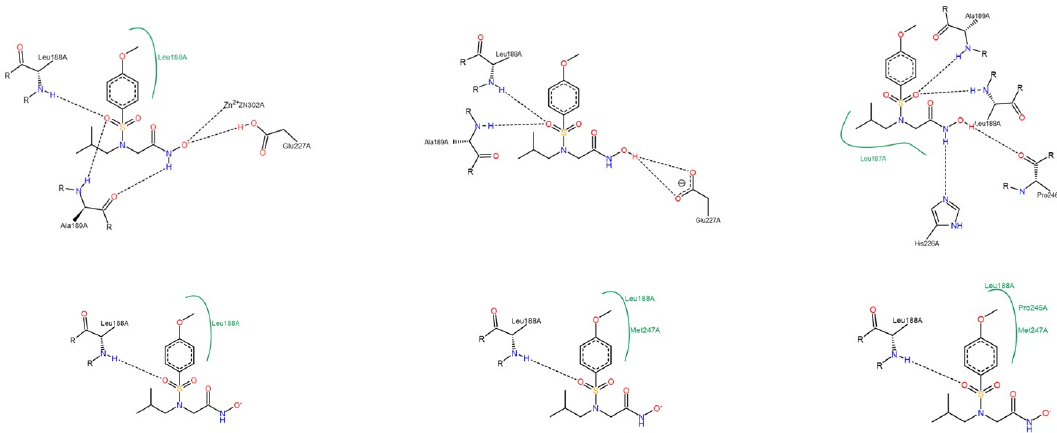
Figure A4. Interactions between NNGH inhibitor and MMP-9, by PoseView calculations.